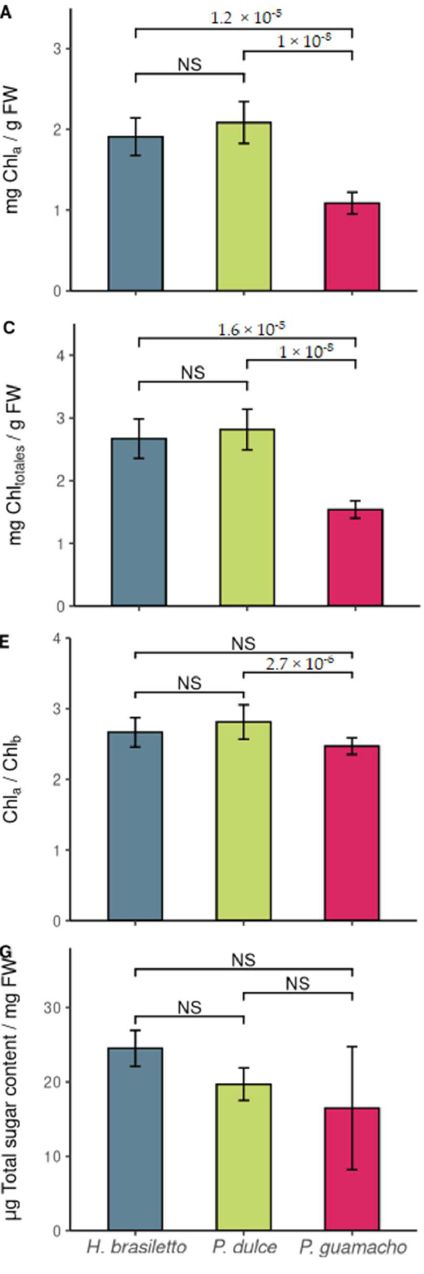
Figure 3. Biochemical traits: ( A ) chlorophyll a (Chl a ); ( B ) chlorophyll b (Chl b ); ( C ) total chlorophylls (Chl total ); ( D ) carotenoid content ( C ); ( E ) Chl a /Chl b ratio; ( F ) proline content; ( G ) total sugar content. Contents measured in the nurse tree species H. brasiletto, P. dulce , and P. guamacho. Values present median ± IQR ( n = 4). The numbers in the upper brackets indicate the p -value, according to the Wilcoxon test for paired species with Bonferroni correction (NS: not significant).